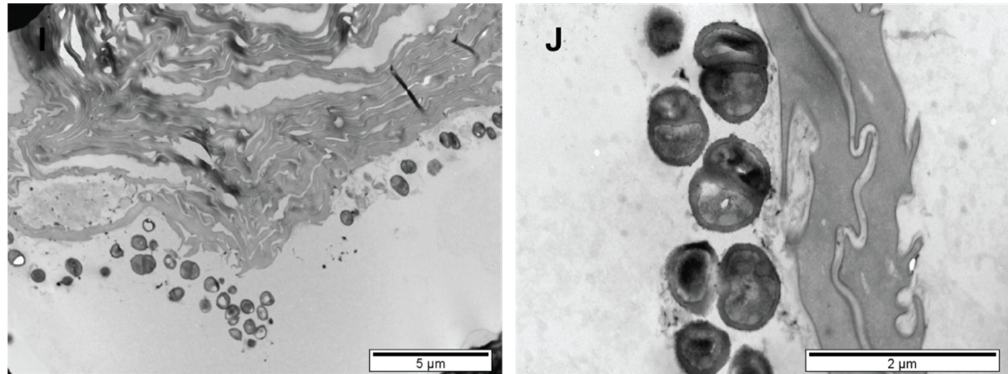
Figure 2. Ultramicroscopic aspects of the middle ear mucosa in deceased COVID-19 patients (TEM): ( A )—Epithelium and subepithelial layer; ( B , C )—Structures suggestive of SARS-CoV-2 virus in epithelial cells (death critical alteration of cellular morphology) (arrows); ( D , E )—Goblet cells with secretory granules; ( F )—Transition area from simple squamous epithelium to respiratory epithelium, guarded by an immune cell; ( G )—Fibrocyte surrounded by collagen fibers in the subepithelial layer; ( H )—Collagen fibers in the subepithelial layer; ( I , J )—Bacterial aggregates on debris (external surface of the tympanic membrane); (E—Epithelium, BL—Basal lamina, SL—Subepithelial layer, F—Fibrocyte, cf—Collagen fibers, g—Secretory granules, m—Microvilli, c—Cilia, IC—Immune cell).